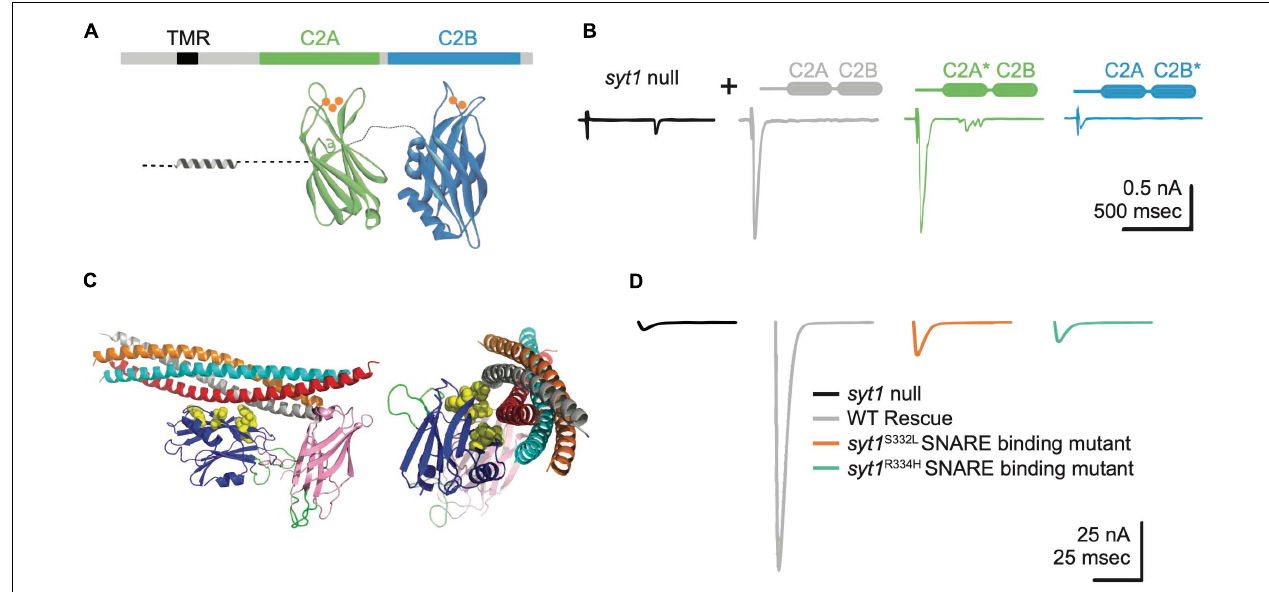
FIGURE 4 | Syt1 binds Ca 2 + and SNARE complexes to trigger synchronous SV fusion. (A) Syt1 is tethered to SV membranes via a transmembrane region (TMR) and has two Ca 2 + -binding C2 domains projecting into the cytosol. Ca 2 + (orange) binds to polybasic loops projecting from each C2 domain, with C2A accommodating 3 Ca 2 + ions and C2B binding 2 Ca 2 + ions. (B) Two-electrode voltage clamp recordings demonstrate syt1 nulls have dramatically impaired evoked synchronous release at Drosophila larval NMJs. Unlike rescue with wildtype (WT) Syt1 (gray trace), transgenes with impaired C2B Ca 2 + binding (C2B*, blue) severely impair evoked release while C2A Ca 2 + binding mutants (C2A*, green) fail to prevent the enhanced asynchronous release observed in nulls (black). Adapted from Yoshihara et al. (2010). (C) The Syt1 C2B domain (blue) also interacts with the SNARE complex at a primary interface independent of the Cpx-associated tripartite binding site. Critical residues coordinating binding of the Syt1 C2B domain to the SNARE complex are highlighted in yellow and were identified from crystal structures of the complex and genetic screens in Drosophila. (D) Disrupting Syt1-SNARE binding at the primary interface with two independent alleles mimics the syt1 null phenotype. Panels (C,D) adapted from Guan et al.